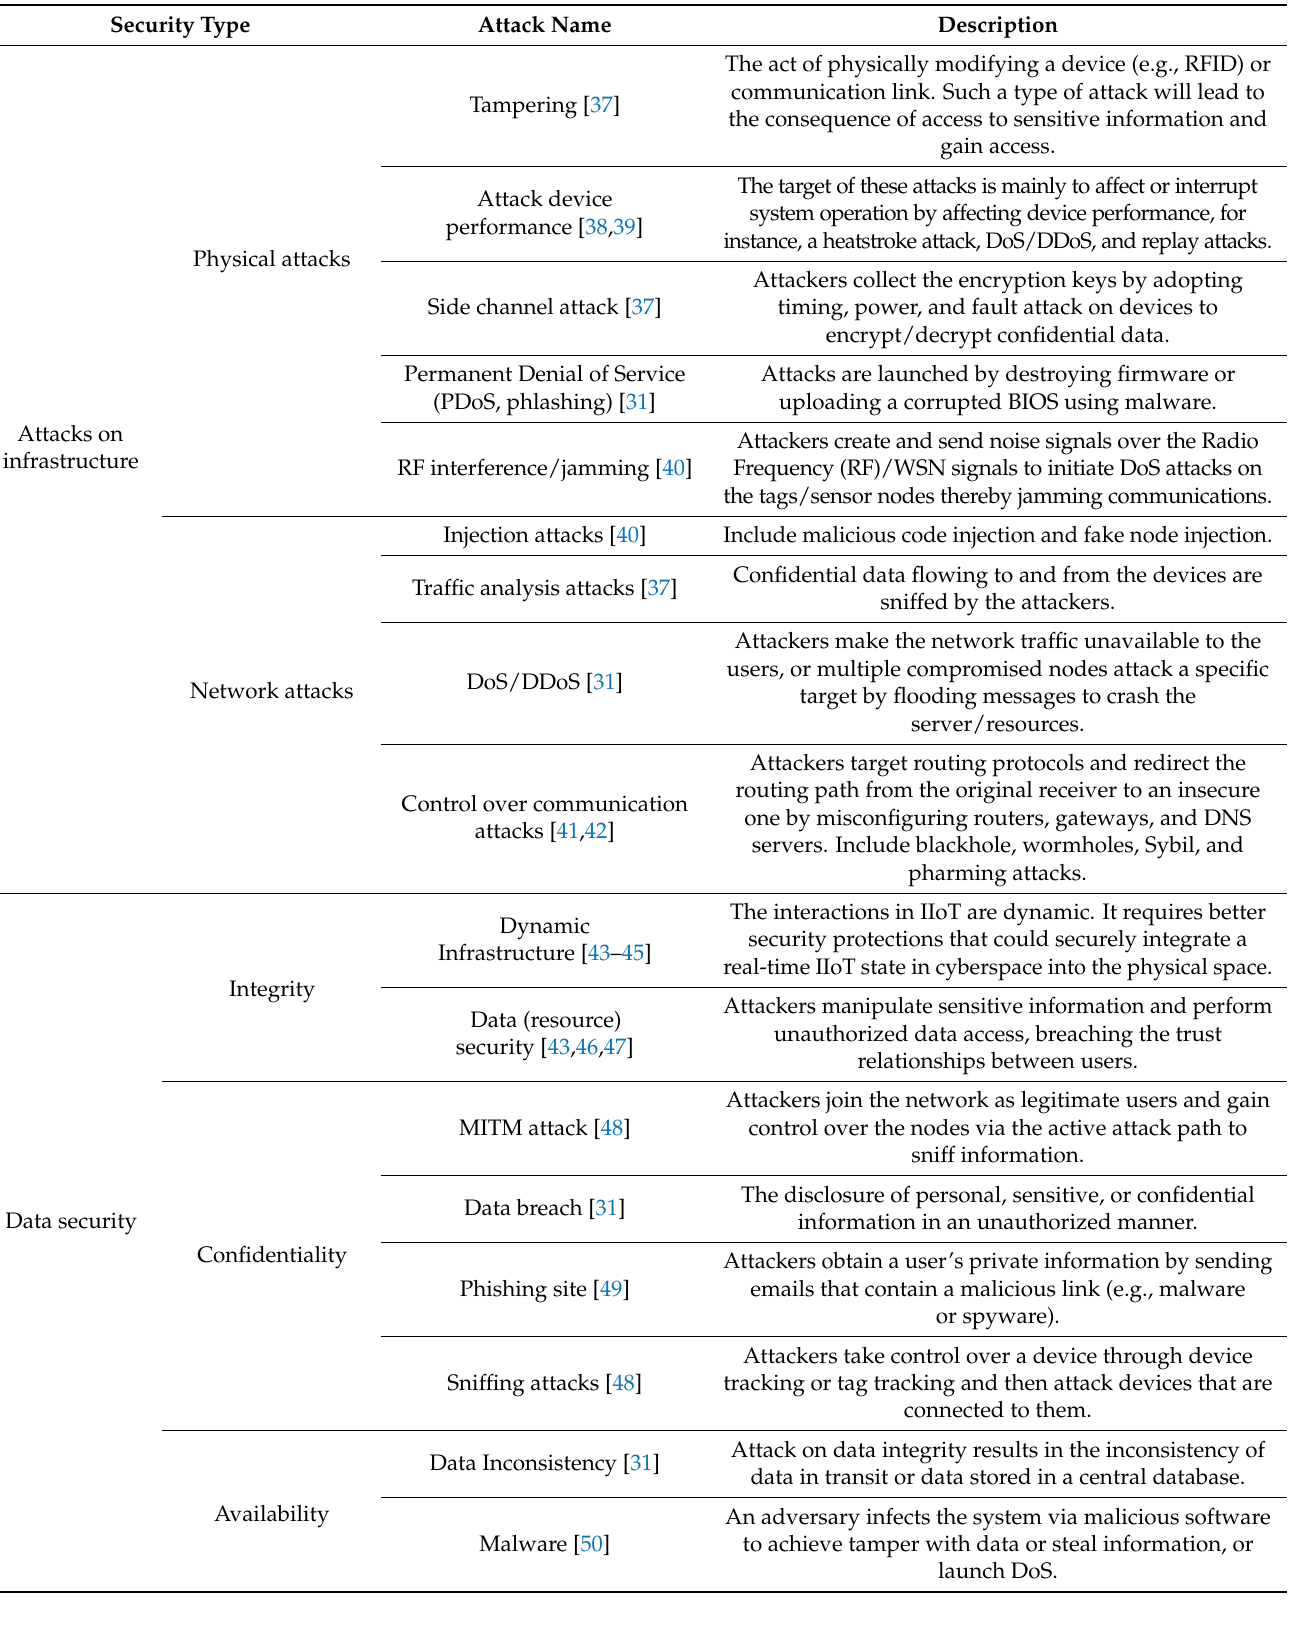
Table 1. The overview of IIoT security